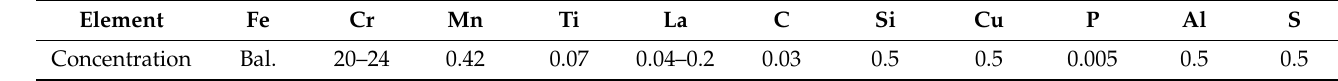
Table 1. Composition of the Crofer 22 APU alloy used in this study (in wt.%).